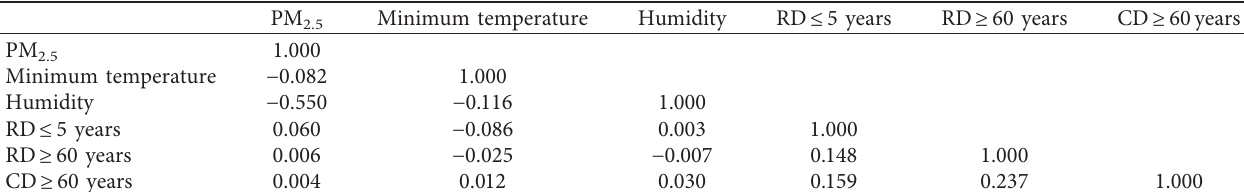
Table 2: Spearman correlation matrix for the variables in the